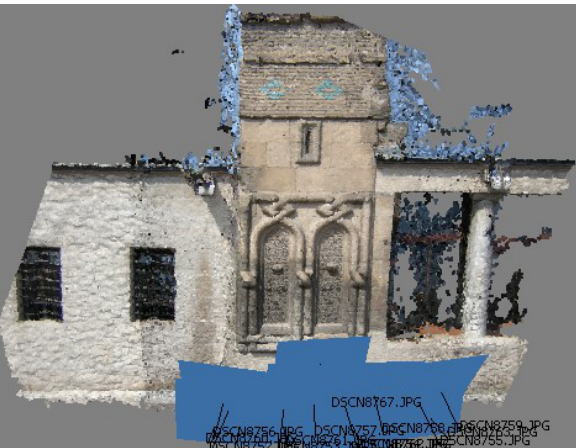
Figure 6. SfM based point cloud from terrestrial